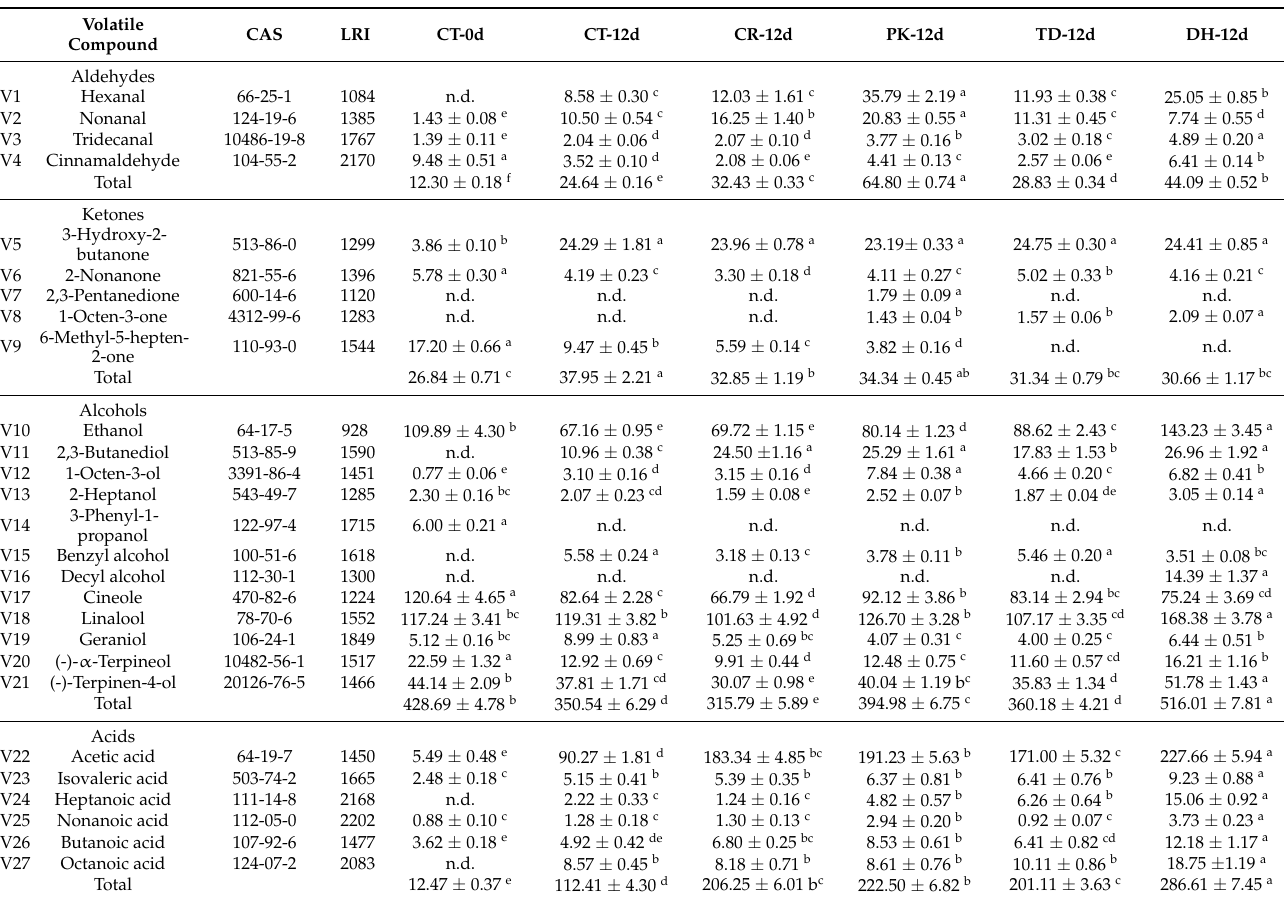
Table 5. Volatile compounds identified and quantified ( µ g/kg) by gas chromatography/mass spec- trometry (GC-MS) of the control and reduced-salt dry sausages with and without yeast inoculation on days 0 and